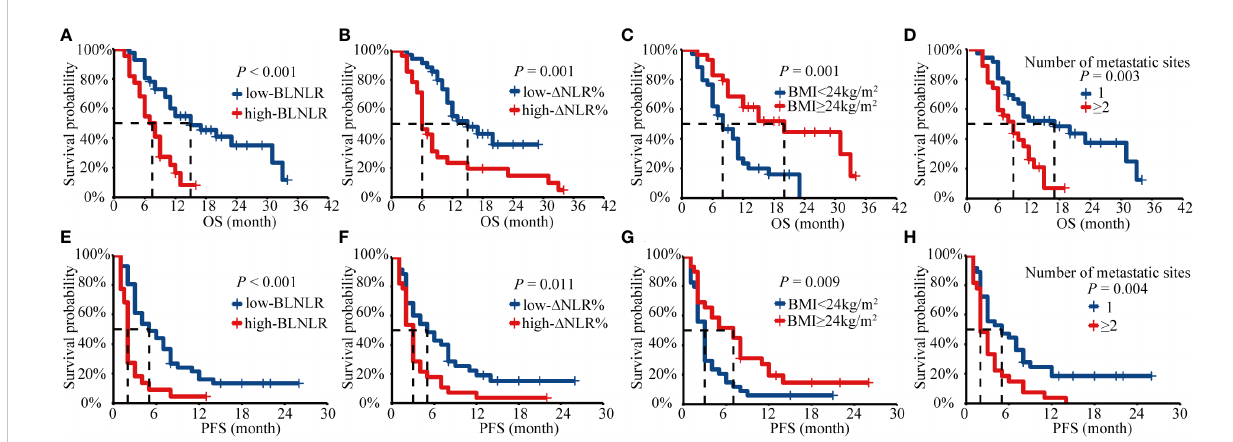
FIGURE 1 Kaplan-Meier analysis of OS and PFS for BLNLR, D NLR%, BMI, number of metastatic sites. (A) OS curve for BLNLR. (B) OS curve for D NLR%. (C) OS curve for BMI. (D) OS curve for number of metastatic sites. (E) PFS curve for BLNLR. (F) PFS curve for D NLR%. (G) PFS curve for BMI. (H) PFS curve for number of metastatic sites. BLNLR, neutrophil-to-lymphocyte ratio before the fi rst cycle of PD-1 inhibitor; D NLR%, relative NLR change (calculated as % change) before the third cycle of PD-1 inhibitor; BMI, body mass index; OS, overall survival; PFS, progression-free